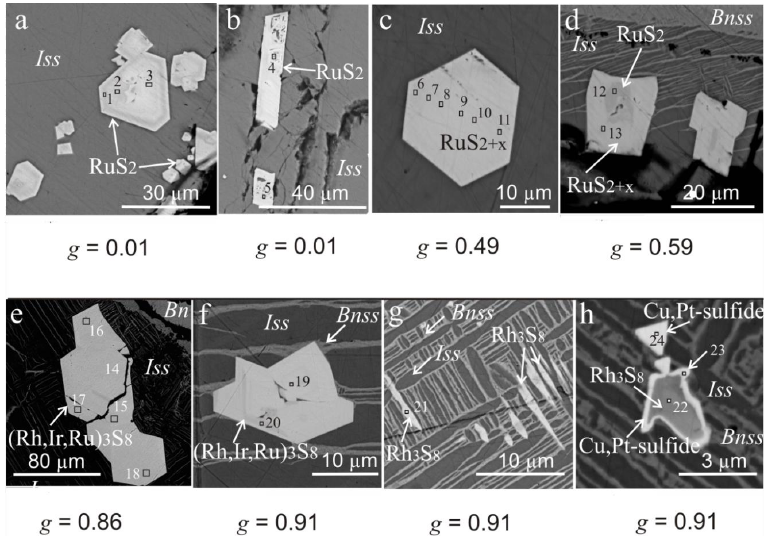
Figure 5. SEM images ( a – h ) of noble metal phases microstructures in sulfide matrices in back-scattered electrons. Numbers 1 – 24 indicate locations of X-ray spectral microanalyses (for values, see Table 3). Table 3. Chemical characterization of microstructural noble metal phases by SEM/EDS 1 .